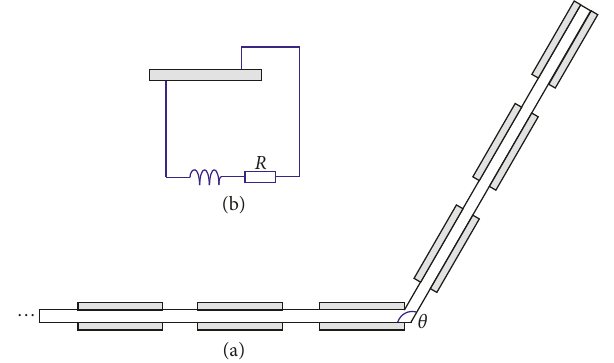
Figure 1: Sketch of the composite beam: (a) L-shape beam with piezoelectric patches and (b) connection pattern of the shunting